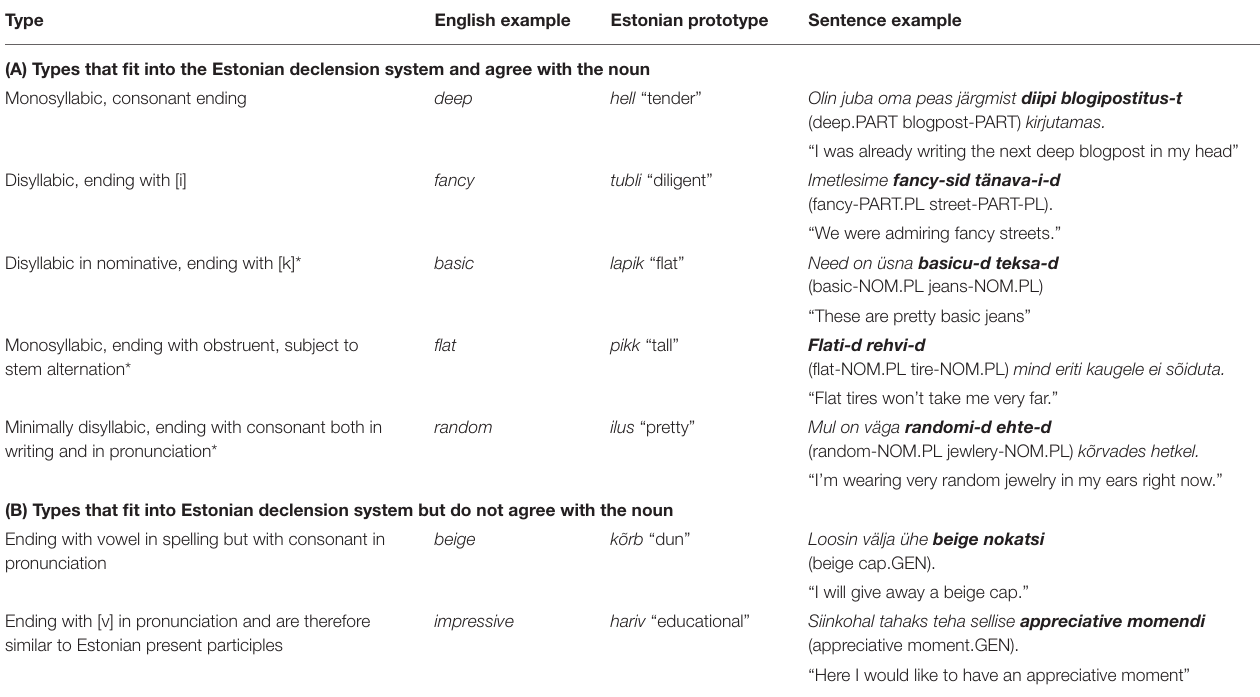
TABLE 1 | Types of English adjectives presented with Estonian prototypes and sentence